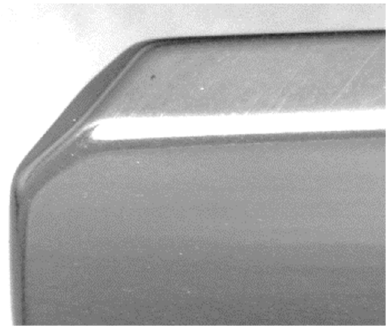
Figure 18. Perfect shapes of top lands, gear edges and chamfers areas achieved in Stream Finishing process for workpiece.